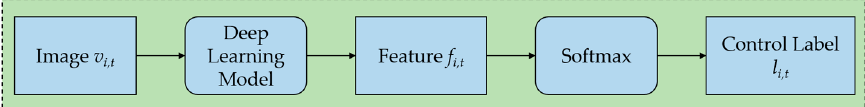
Figure 5. The deep learning model is a process of inferring control signals using video.